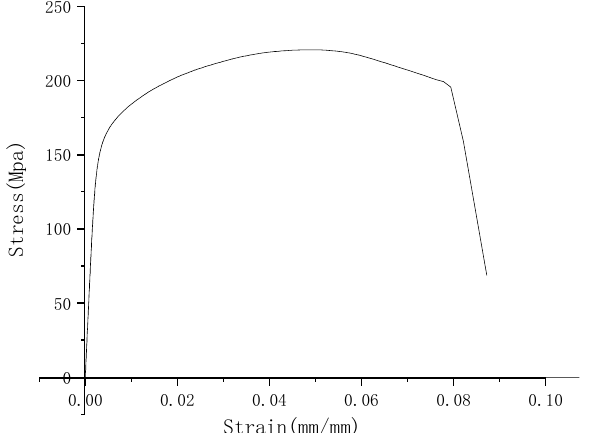
Figure 4. Stress-strain curve of dissimilar lightweight materials welded joints with precrack after impact loading. Table 3. Mechanical properties of specimens after impact loading.